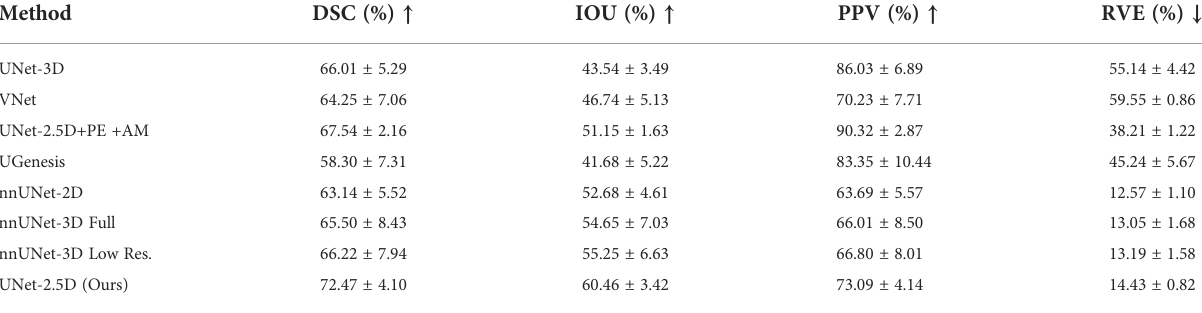
TABLE 2 Comparative result of different deep neural network architectures for DSC, IOU, PPV and RVE.